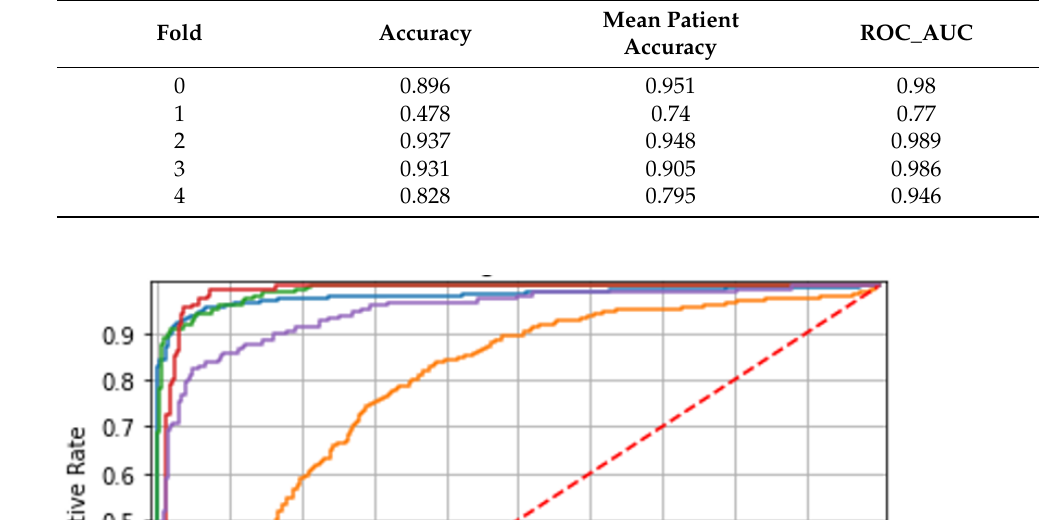
Figure 3. Experiment 3 — Classification of PillCam Crohn CE images by a combined model. Table 4. Experiment 4 — Identification of colonic ulcerated mucosa.